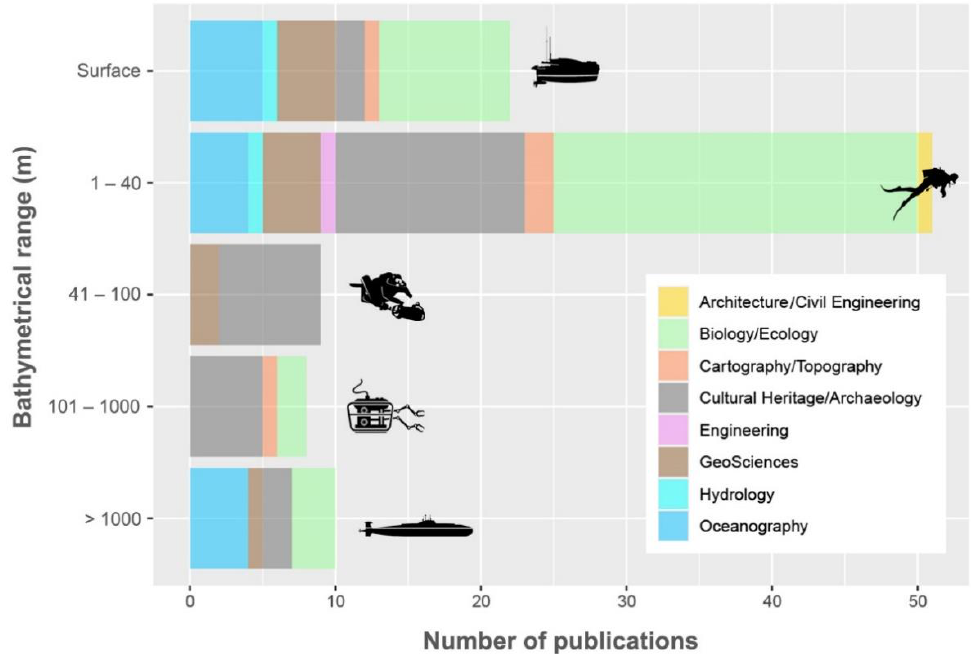
Figure 6. Bathymetric distribution of underwater photogrammetric approaches with the relative disciplines of implementation. Icons indicate the main but not exclusive tools applied at each depth range.